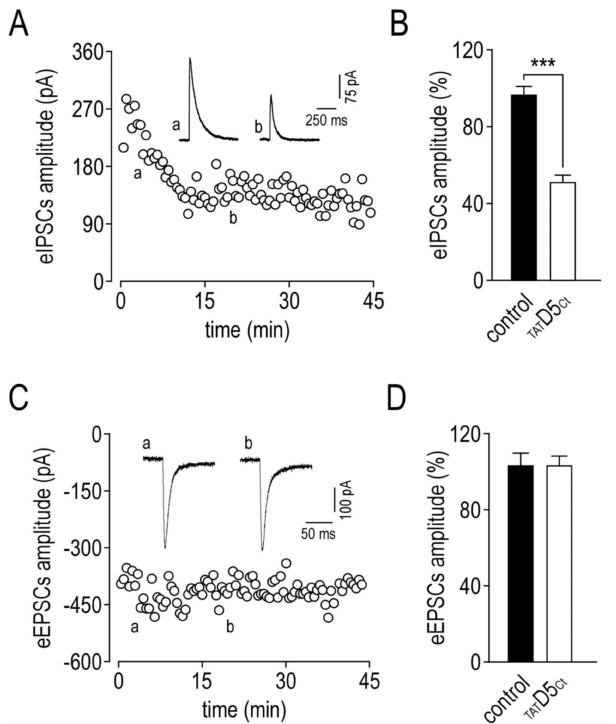
Figure 9. Evoked GABA A receptor-mediated IPSCs recorded in hippocampal CA1 pyramidal neurons are depressed by the disrupting peptide. ( A ) eIPSCs amplitude versus time (recorded at a holding potential of − 40 mV) with the disrupting peptide added in the patch pipette (10 µ M). The inset shows example traces of eIPSCs two minutes after the achievement of the whole-cell configuration (a), and at the maximal time effect of the disrupting peptide (b). For this figure and the next, stimulus artefacts were digitally removed. ( B ) Summary data comparing the effects of control and disrupting peptide on eIPSCs amplitude (represented as mean ± SEM at t = 20 min, normalized to the amplitude at t = 2 min. *** p < 0.001. Nonparametric Mann–Whitney test). Experiments in the presence of 50 µ M D-AP5 and 2 µ M NBQX. ( C ) Evoked AMPA receptor-mediated EPSCs amplitude versus time (recorded at a holding potential of − 70 mV) with the disrupting peptide added into the patch pipette (10 µ M). The inset shows example traces of eEPSCs 2 min (a) and 20 min (b) after the achievement of the whole-cell configuration. ( D ) Summary data comparing the effects of control and disrupting peptide on eEPSCs amplitude (represented as mean ± SEM at t = 20 min, normalized to the amplitude at t = 2 min). Experiments in the presence of 10 µ M